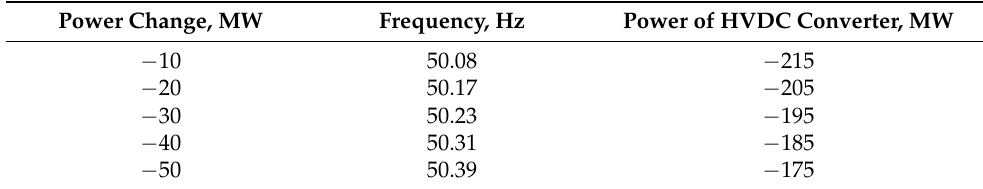
Table 4. Frequency change in the isolated power